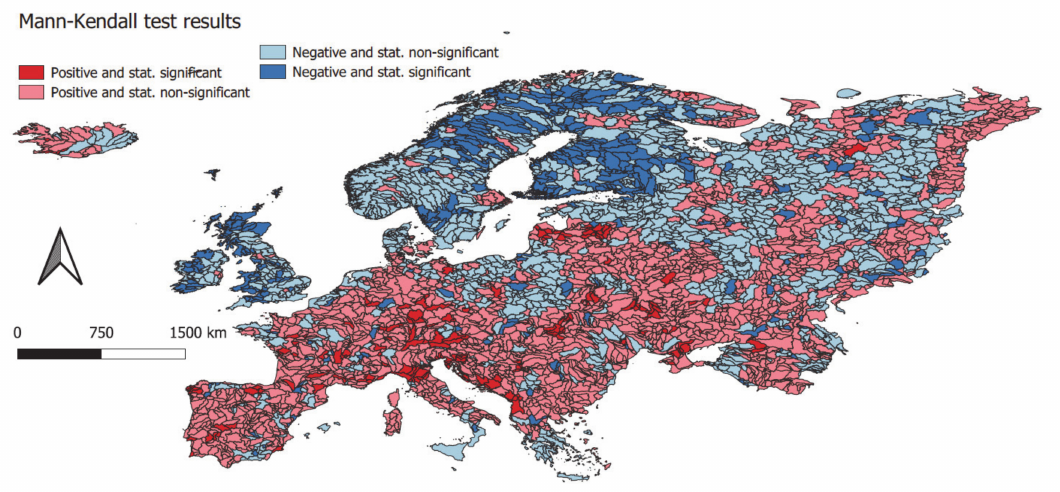
Figure 3. Mann–Kendall trend test results using the mean annual number of days with a compound occurrence of drought and extreme heat in the 1961–2018 period. Results for the basic case and N = 365 days are